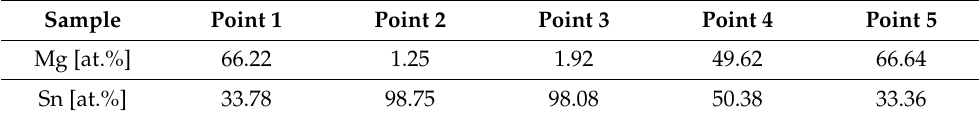
Figure 2. XRD pattern of as-cast Mg 2 Sn alloy.